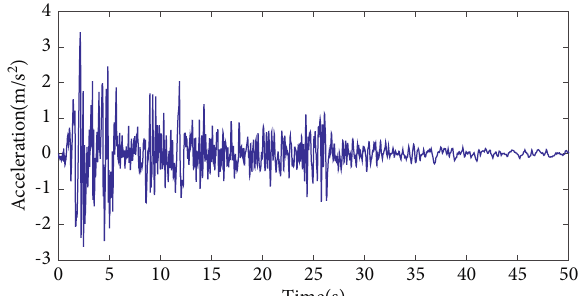
Figure 4: El Centro (1940) earthquake N-S component of ground motion acceleration record.